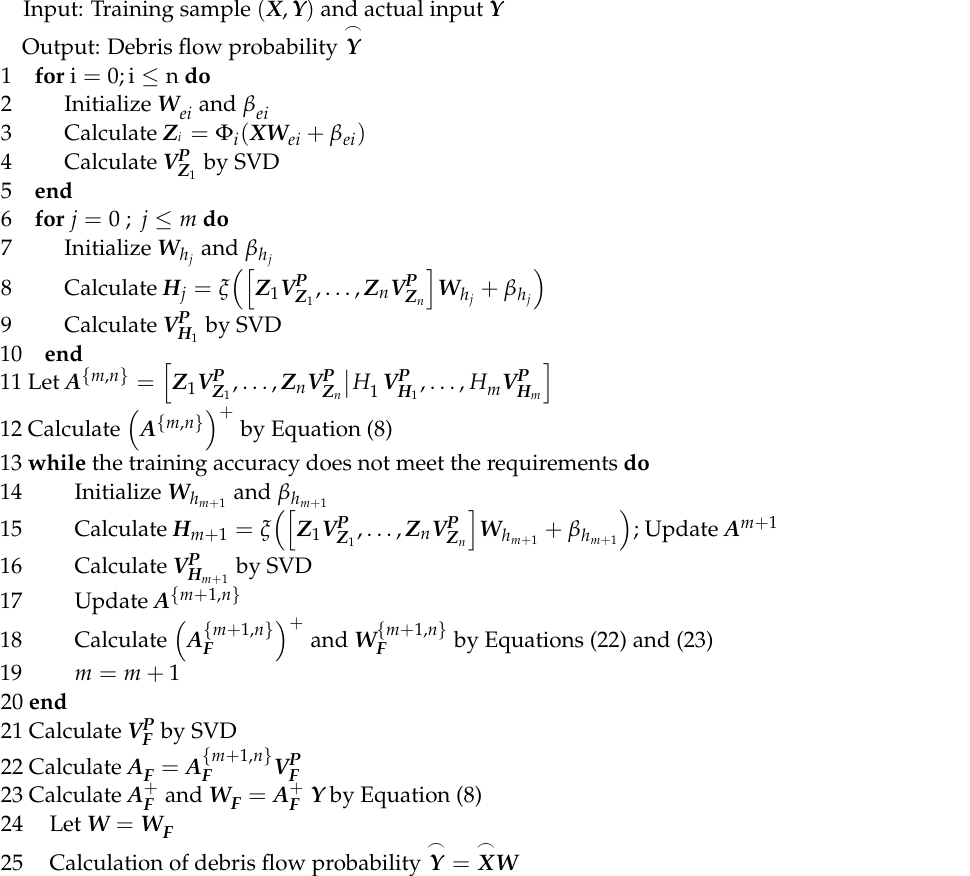
Algorithm 1 Debris flow prediction based on the SVDBL